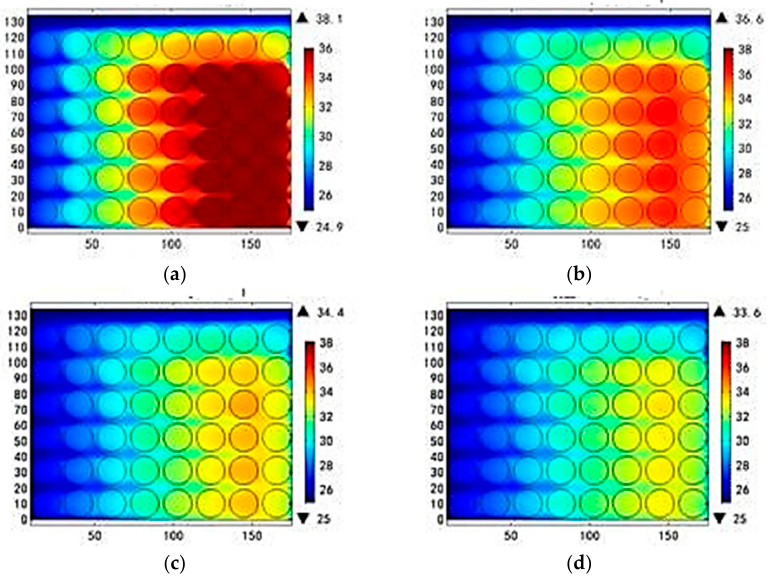
Figure 3. Battery temperature profiles at different inlet air velocity. ( a ) 0.7 m/s; ( b ) 0.8 m/s; ( c ) 1.0 m/s; ( d ) 1.1 m/s at 25 ◦ C and 1C discharging